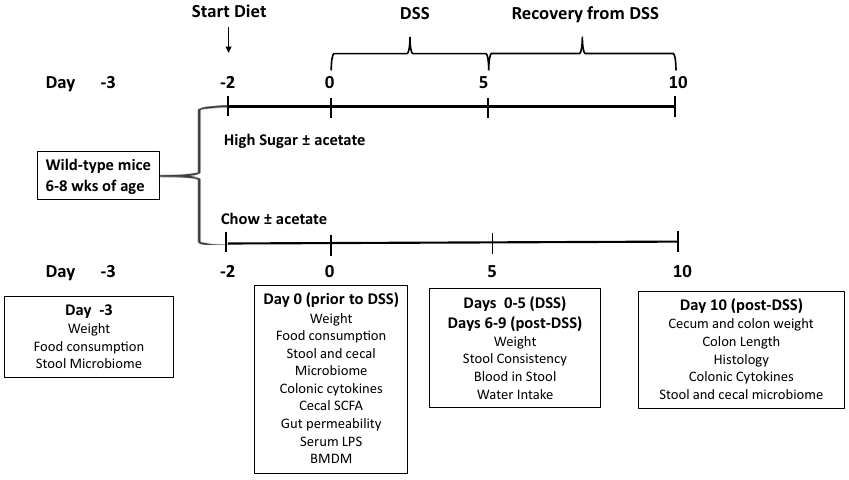
Figure 1. Experimental Design. Female mice on a 129S1/SvimJ background were raised on chow until 6–8 wks of age and then placed on either a chow diet (CH) (LabDiet 5001) or a high- sugar diet (HS) (50% Sucrose; Harlan Teklad AIN76A) (Day -2). After two days on the diet, mice were treated with dextran sodium sulfate (DSS 3%; MW 35– 45,000 kDa; MP Biomedicals) added to their drinking water (Day 0). After five days, DSS was removed and replaced with regular drinking water for a further 5 days. Mice were sacrificed on the tenth day and tissues collected and snap frozen for further study. Weight and stools were collected on day -3 prior to the diet switch. The effect of two days on the diet (Day 0) on stool and cecal microbiome, colonic cytokine concentrations, cecal SCFA levels, gut permeability, and serum LPS was assessed. Body weight, stool consistency, and fecal occult blood (FOB) were measured daily from day 0 (start of DSS) to day 10. A parallel group of mice received acetate (NaAc:300 mM) in the drinking water throughout the experiment beginning at day -2 when the mice were switched to the different